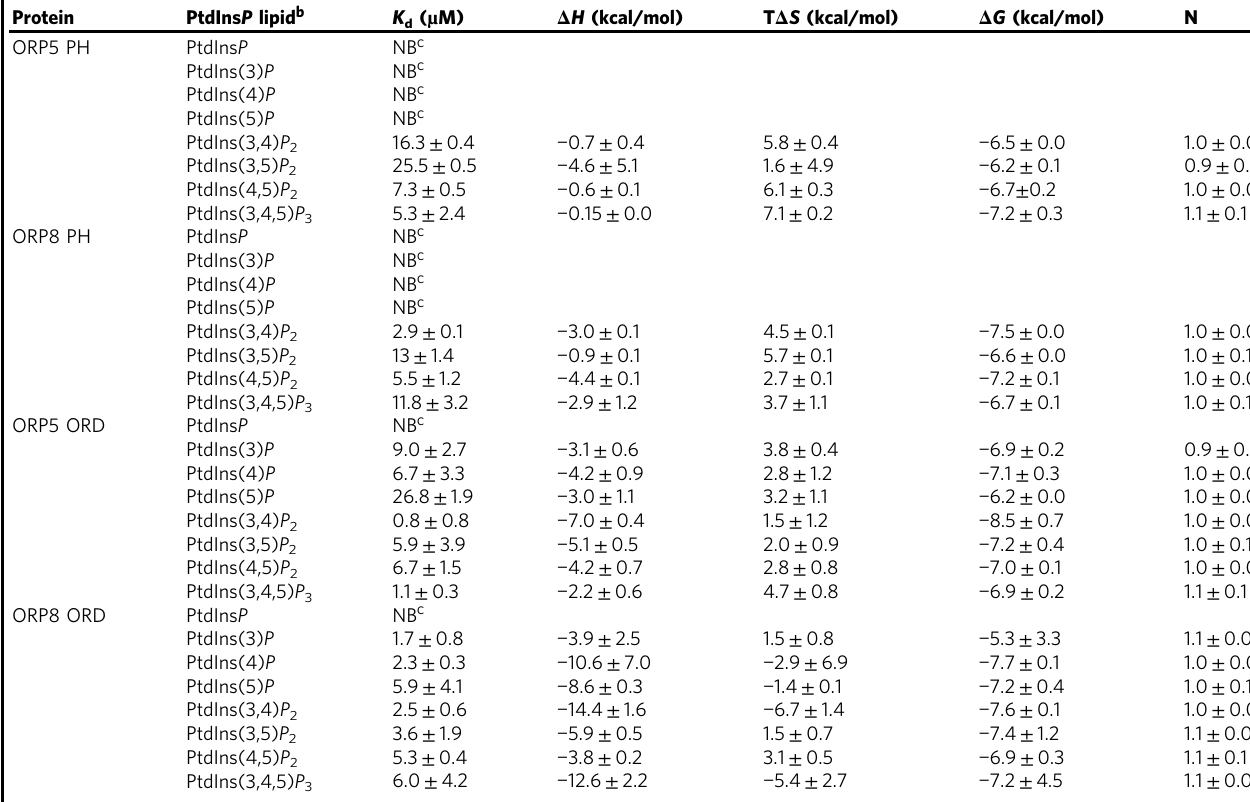
Table 1 Thermodynamic parameters for the binding of PtdIns P s with ORP5 and ORP8 by ITC a